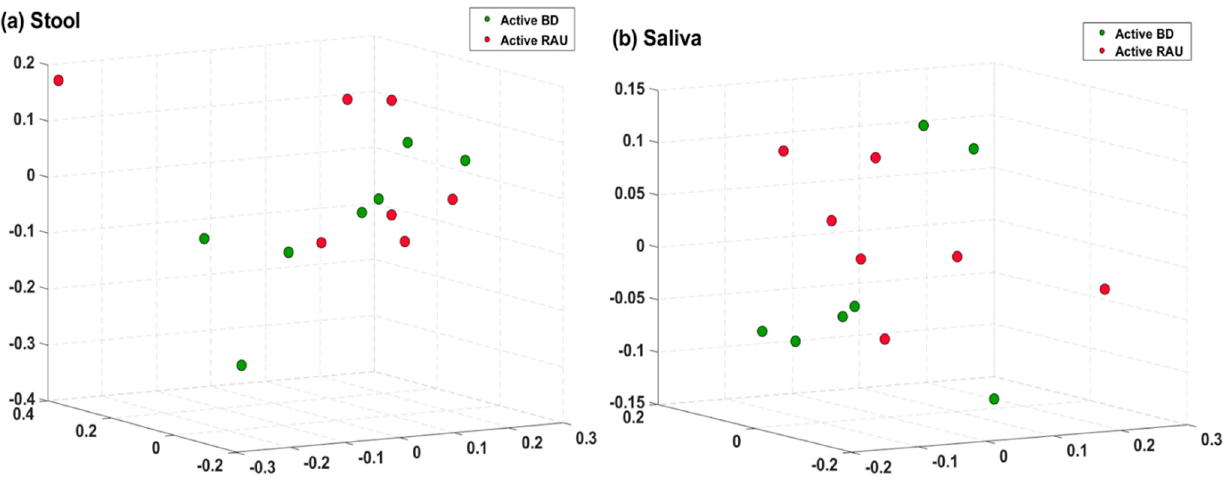
Figure 7. Comparison of the taxonomic beta diversities of microbiomes of the active BD (green) and inactive BD (green) groups. Differences in beta diversity between the groups were visualized using Bray-Curtis principal coordinate analysis (PCoA) plots in a three-dimensional space. The significant p-values of the differences in beta diversity between groups were evaluated using permutational multivariate analysis of variance (PERMANOVA). In stool ( a ) and saliva ( b ), there were no significant differences in the beta diversity between groups. BD, Behçet’s disease.